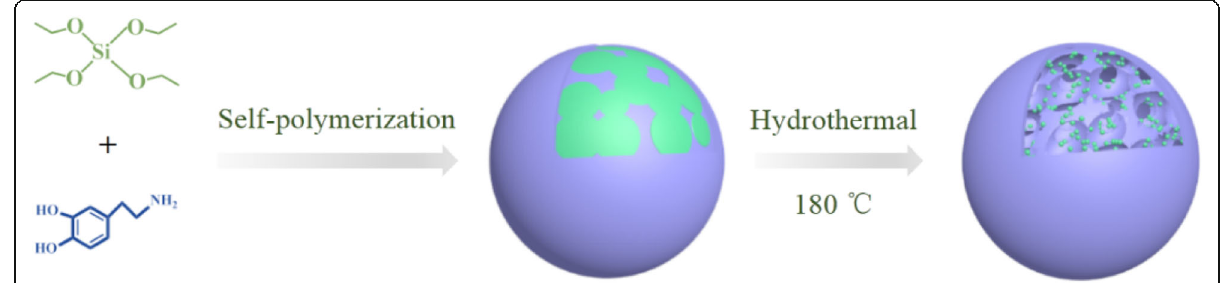
Scheme 1 The illustration of PPM sorbents ’ synthesis